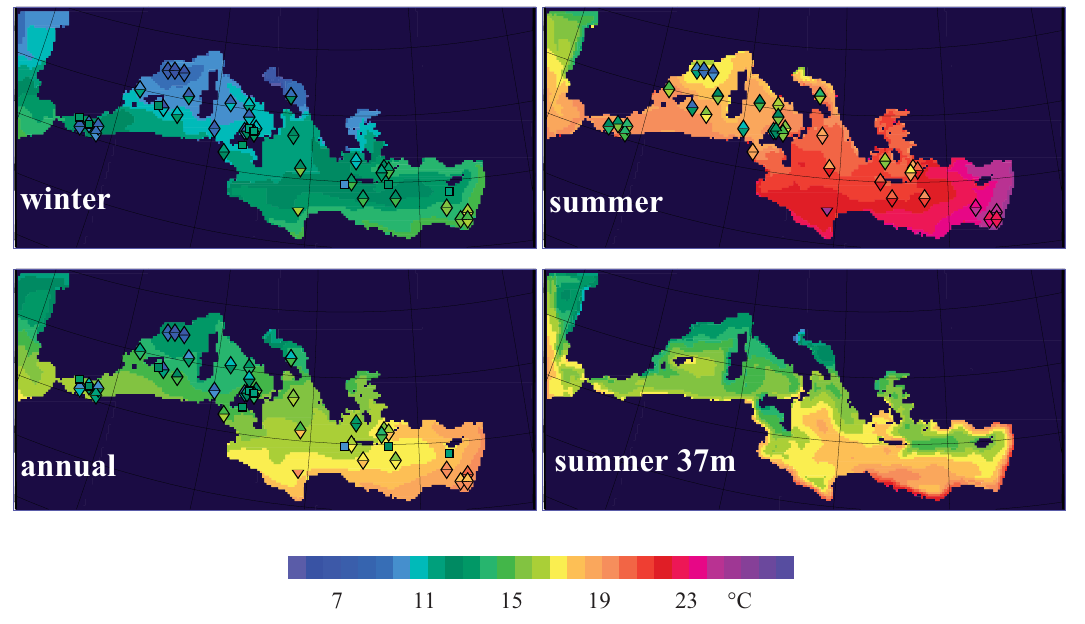
Fig. 7. Simulated temperature in the LGM simulation in ◦ C. Winter (JFM) SST, annual mean SST, summer (JAS) SST and summer temperature at 37m depth. Downward triangles represent ANN reconstructions, upward looking triangles represent RAM reconstructions (Hayes et al., 2005). Alkenone derived temperature estimates (Lee, 2004) are represented by squares. Extending the suggestion by Emeis et al. (2000), alkenone temperature estimates have also been plotted for